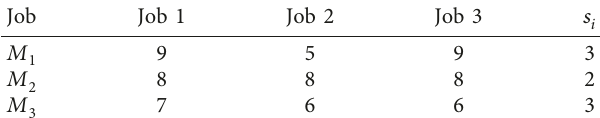
Table 1: The processing time of 3 jobs on 3